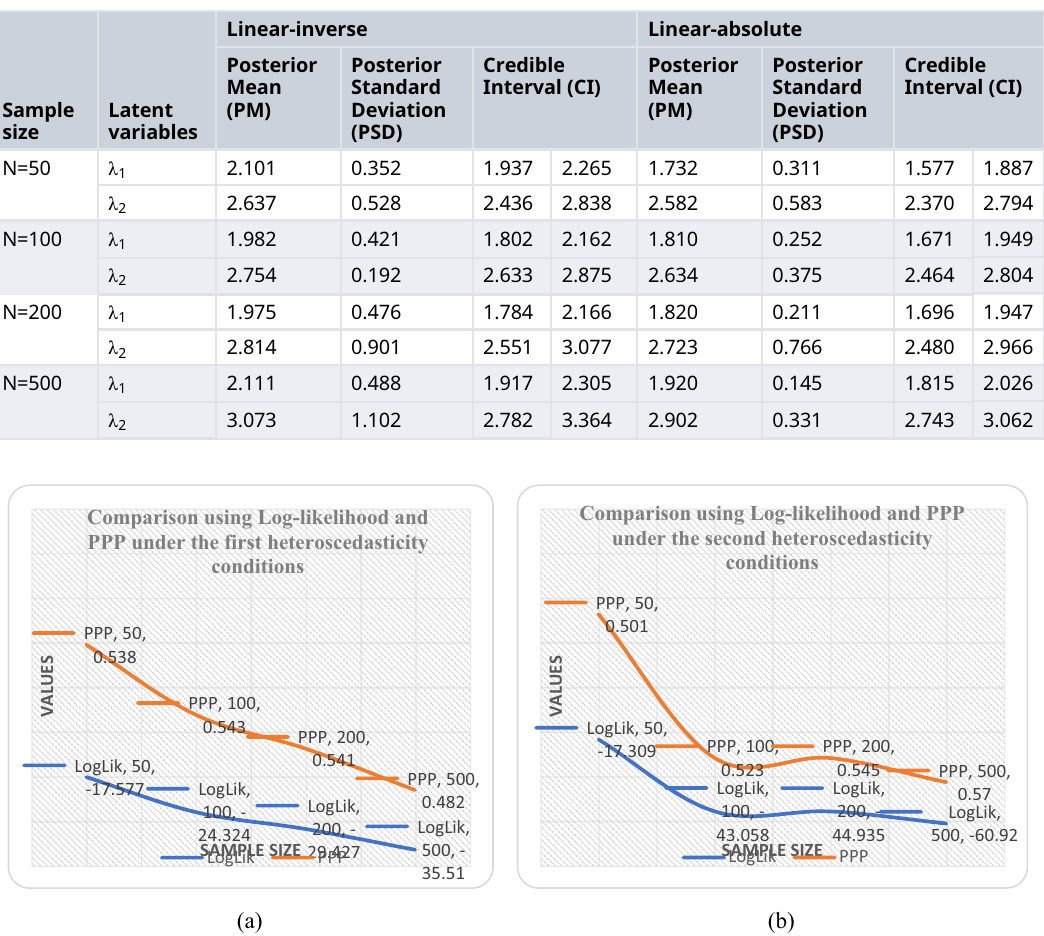
Table 7. Latent variable estimates at different sample sizes under the linear-inverse and linear absolute forms.